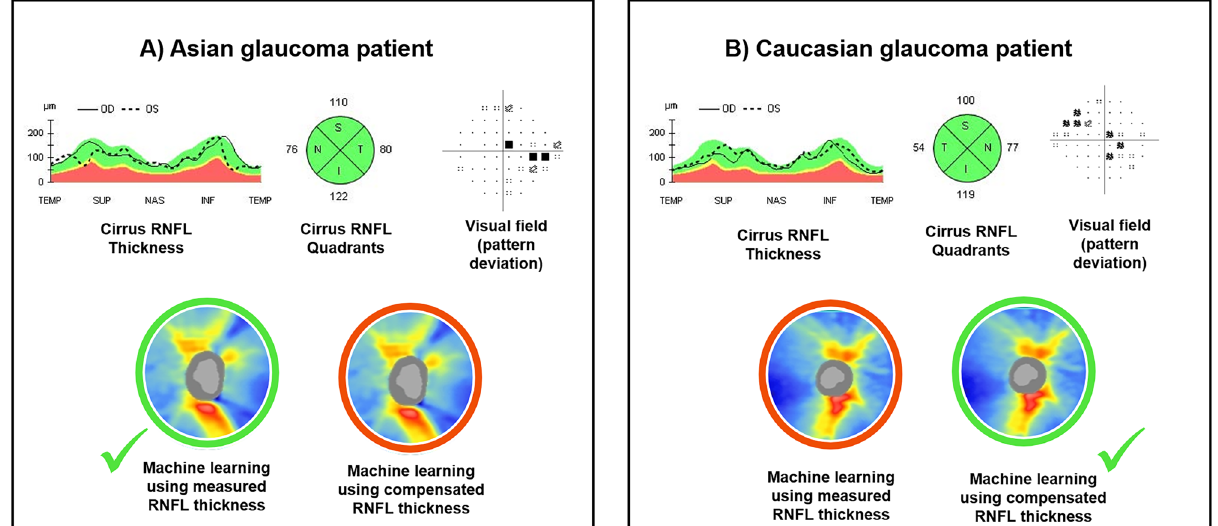
Figure 3. Representative glaucoma cases showing the diagnostic performances of the measured retinal nerve fiber layer (RNFL), machine learning model using measured RNFL thickness, and machine learning model using compensated RNFL thickness. Case ( A) is an Asian glaucoma patient, while Case ( B ) is a Caucasian glaucoma patient. The Cirrus RNFL thickness maps indicate a reduction in the RNFL thickness in the superior and inferior regions in Case ( A ), while it shows a reduction in the superior regions in Case ( B ). However, the Cirrus quadrant analyses show a normal RNFL probability color code in all quadrants in both cases. The output prediction of both compensation and machine learning approaches are color-coded, where the red circle indicates wrong prediction, and the green circle indicates correct prediction. The machine learning model measured RNFL thickness correctly predicted Case ( A ) with glaucoma while the machine learning model using compensated RNFL thickness correctly predicted Case ( B ) with